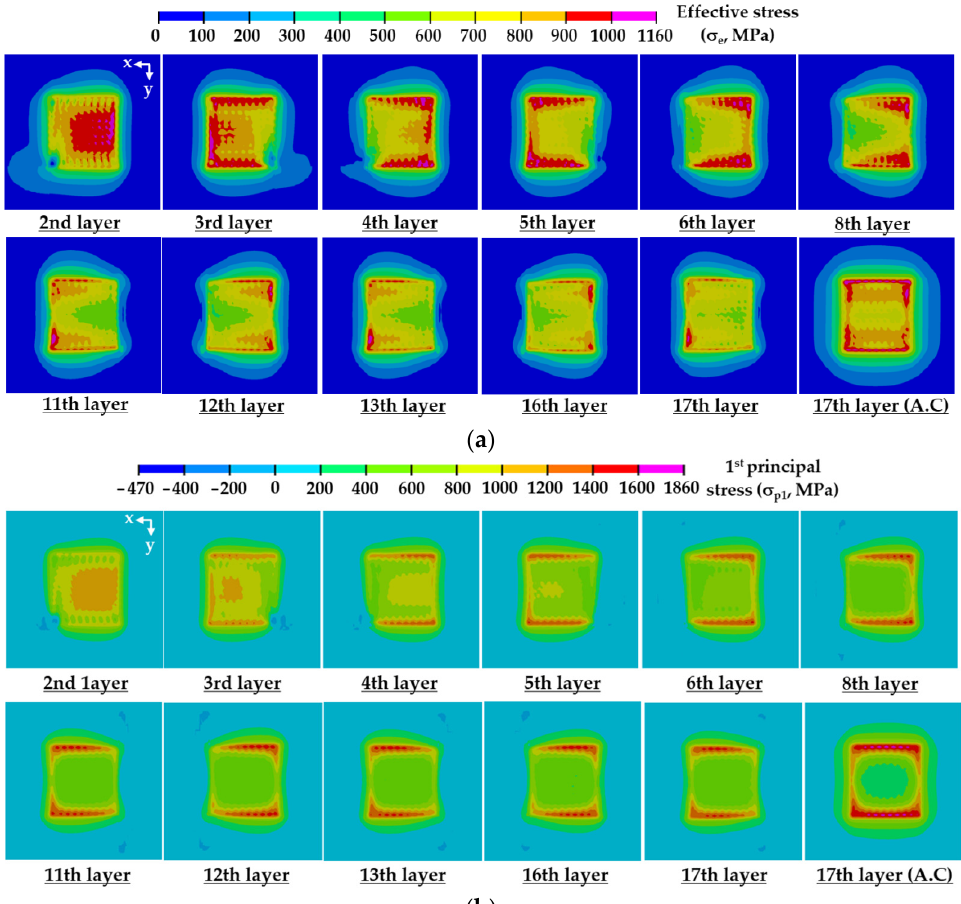
Figure 14. Residual stress distributions after deposition of each layer (large volume deposition, type 5 path of ADDS): ( a ) effective stress distributions; ( b ) first principal stress distributions.